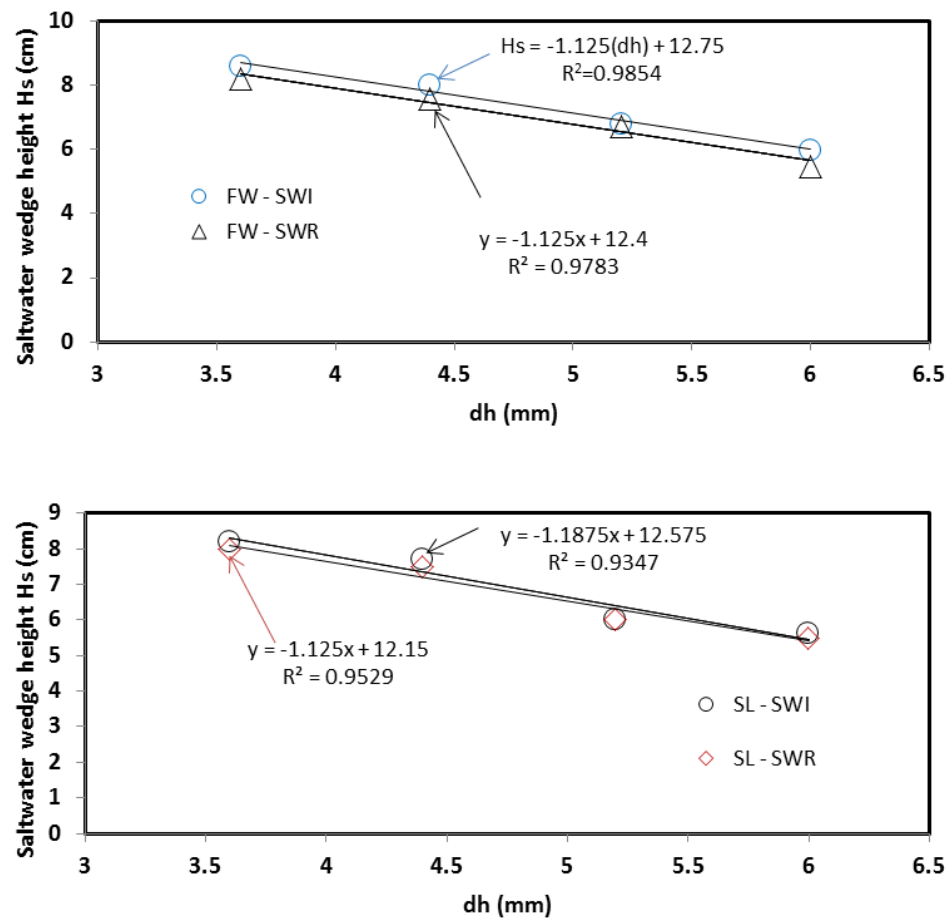
Figure 7. Steady-state to steady-state saltwater wedge height H s against the head difference dh in case 1090 following fluctuations of the freshwater head boundary ( top ) and saltwater boundary ( bottom ). SWR refers to saltwater retreat, while SWI refers to saltwater intrusion.